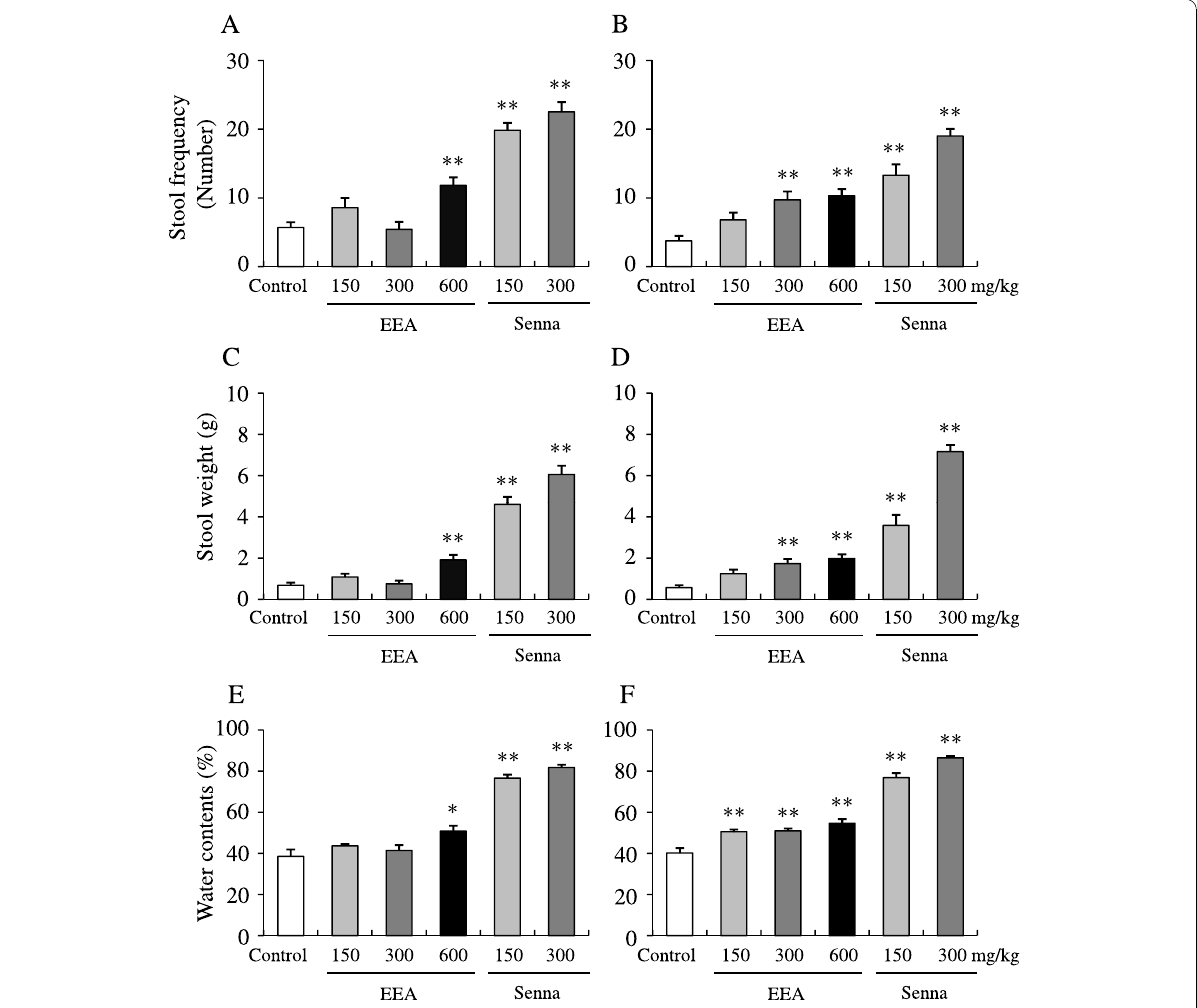
Figure 4 Effect of single (A, C and E) and 14-day (B, D and F) administrations of EEA and senna on stool frequency, weight and watercontent on rats with low fiber diet-induced constipation . Data are shown as the mean ± S.E.M., n = 12, **p < 0.01, *p < 0.05 vs. vehicle (paired Tukey ’ s multiple comparison